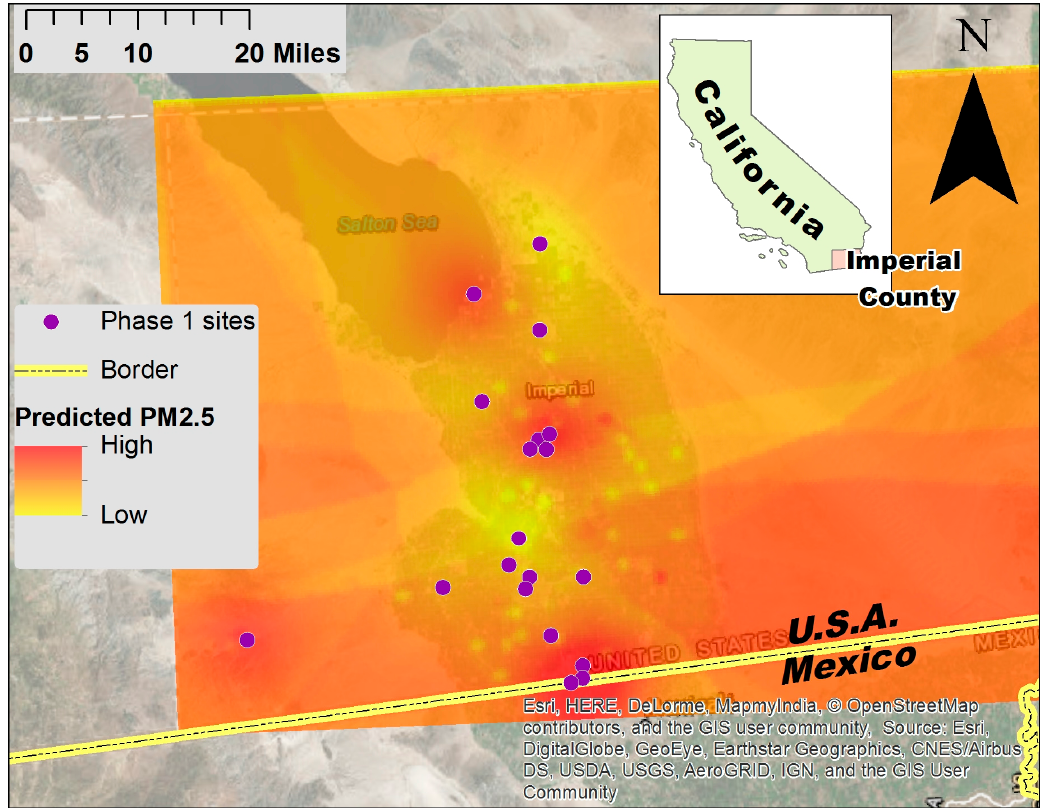
Figure 3. Modeled air pollution concentrations. Purple dots indicate locations of Phase 1 monitors.